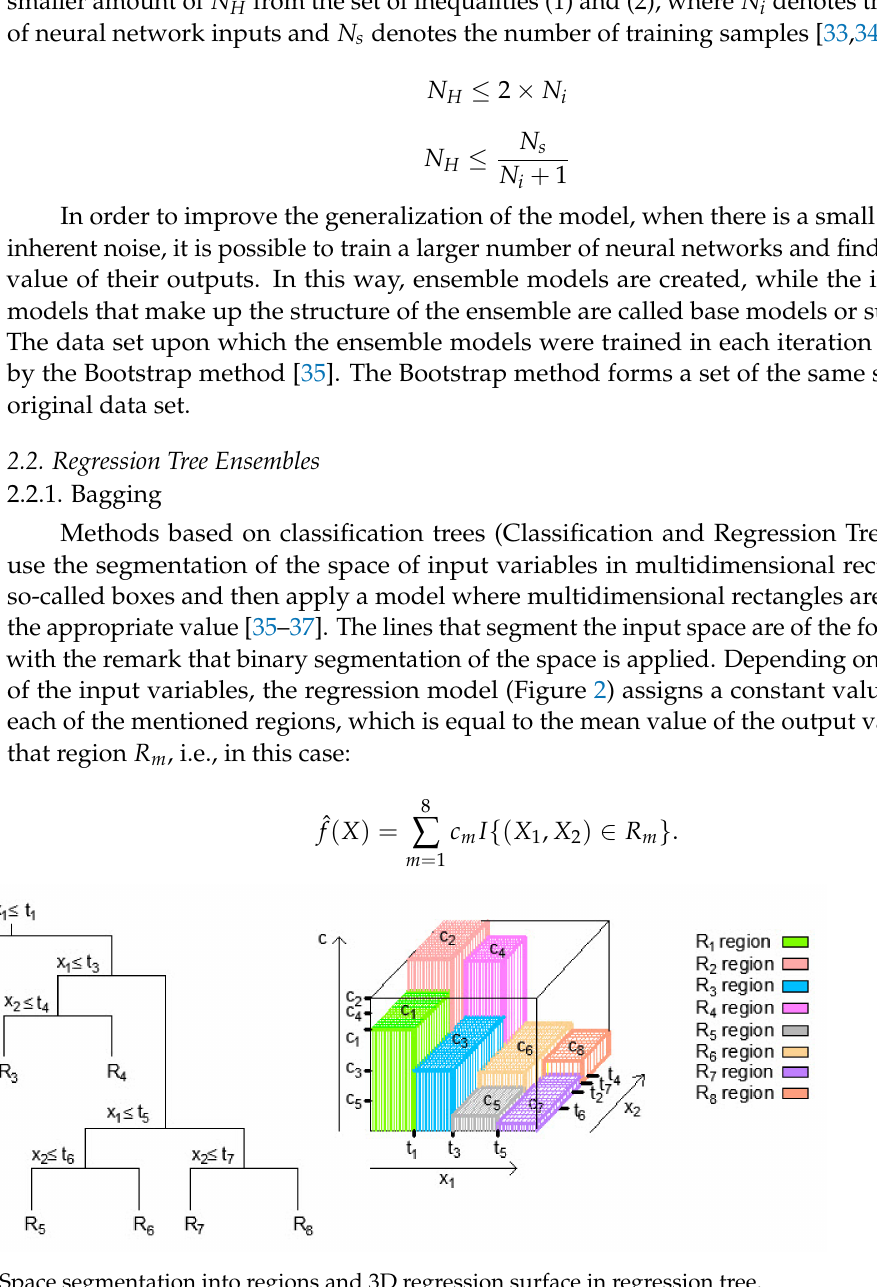
Figure 2. Space segmentation into regions and 3D regression surface in regression